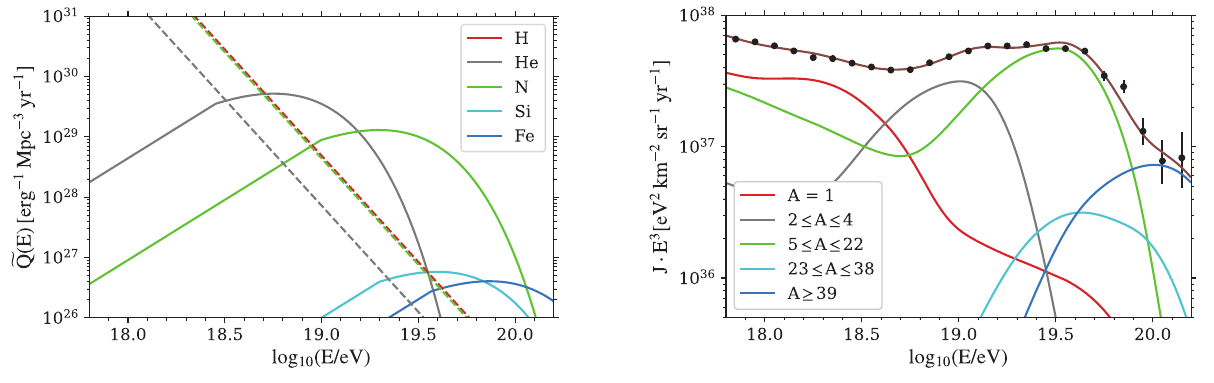
Figure 2. S cenario 2. Left: The generation rate at the extragalactic sources for each representative mass; the LE and HE contributions are shown as dashed and solid lines, respectively. Right: The corresponding extragalactic (grouped according to mass number) contri- butions to the energy spectrum at the top of atmosphere.